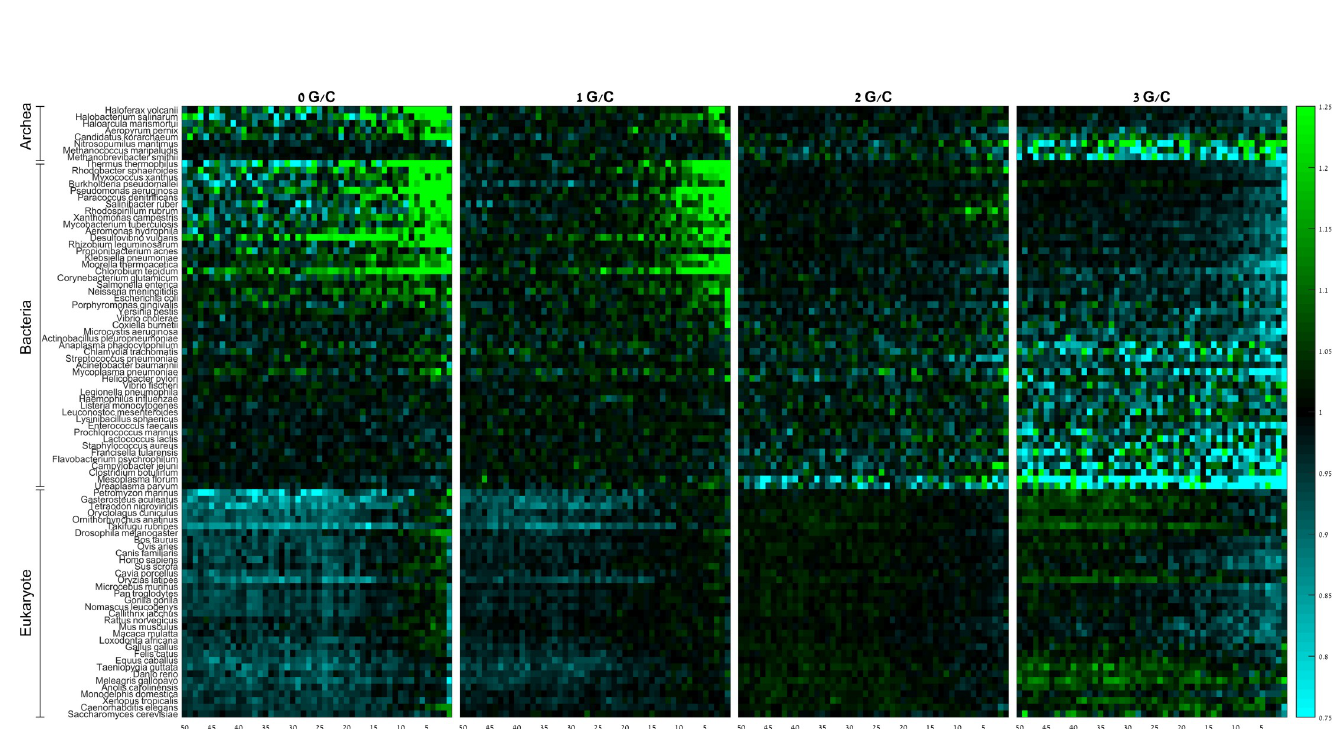
Fig 3. Group RSCA scores of codons containing 0, 1, 2, and 3 G/C nucleotides along the last 50 codons of the gene. Rows denote species, columns denote positions. Species within domains are sorted from high (top) to low (bottom) GC-content.